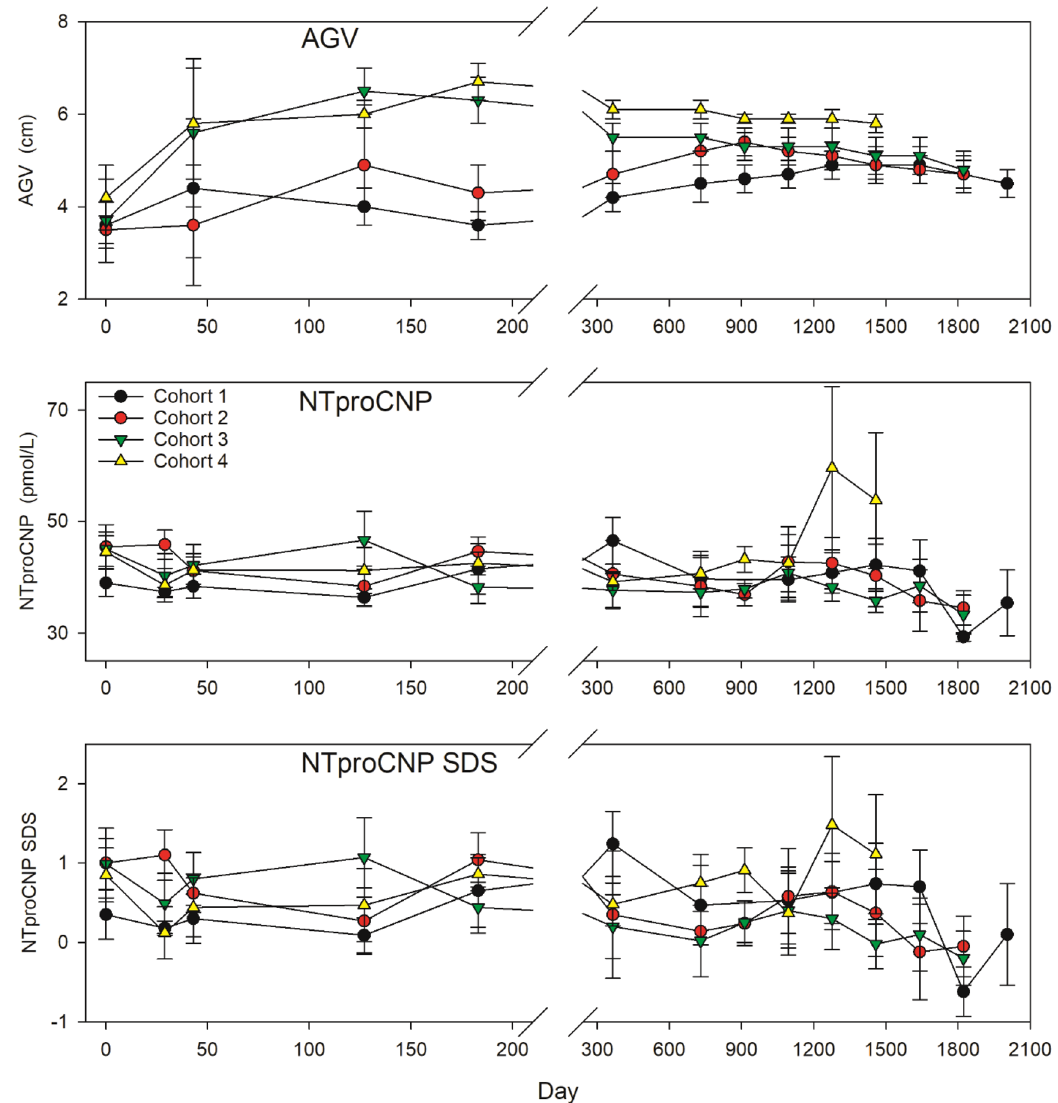
Figure 1. Annualised growth velocity (AGV), plasma NTproCNP concentrations and NTproCNP SDS (adjusted for age and sex) by cohort across the study. Values are mean ± SE. Cohort 1 (6 subjects, age range 6–10 year at screening) received 2.5 µg/kg/day for up to 10 months (~ to day 300), followed by 7.5 µg/kg/day for approximately 2 months (~ to day 360), and thereafter 15 µg/kg/day until study completion. Cohort 2 (6 subjects, age range 5–10) received 7.5 µg/kg/day for the initial 6–8 months (180–240 days)—escalating to 15 µg/ kg/day thereafter. Cohorts 3 (8 subjects, age range 6–11) and Cohort 4 (8 subjects, age range 5–8) received 15 µg/kg/day and 30 µg/kg/day respectively throughout the study. Expected average AGV in normal children and in untreated Ach is 6 and 4 cm/year respectively 13,27 Acute exposure to exogenous CNP analogue inhibits NTproCNP production. The impact of